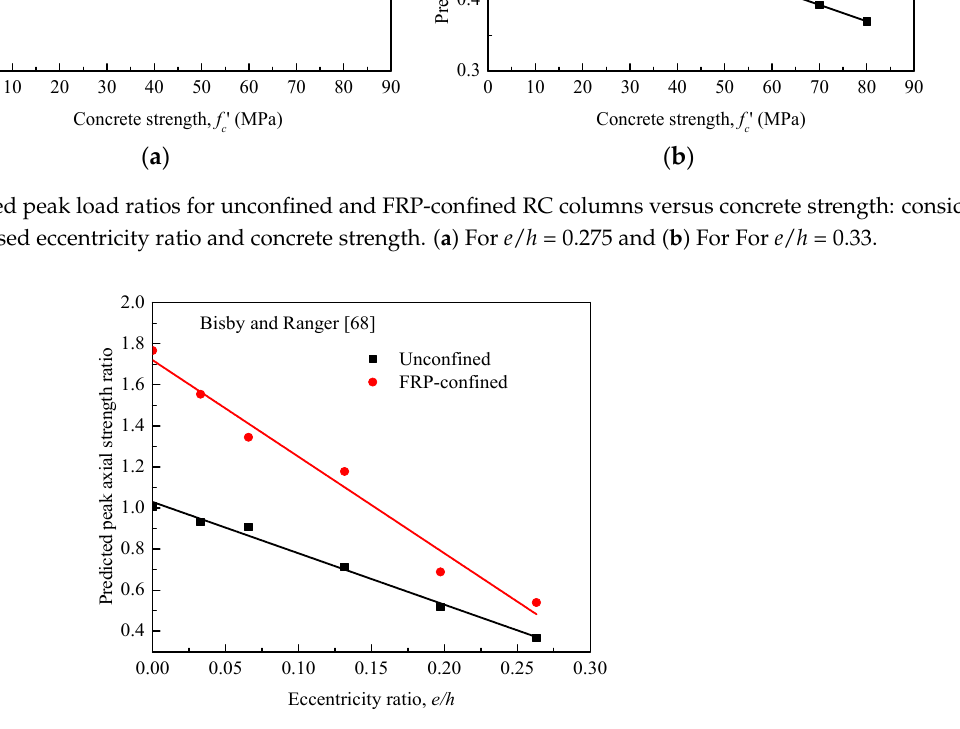
Figure 15. Normalized peak compressive axial load versus load eccentricity (Bisby and Ranger [68]).